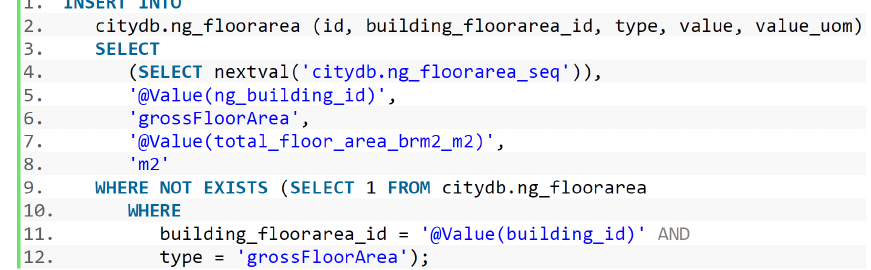
Figure 5. SQL statement to insert the floor area to the ng_floorarea table in a 3DCityDB with Energy ADE